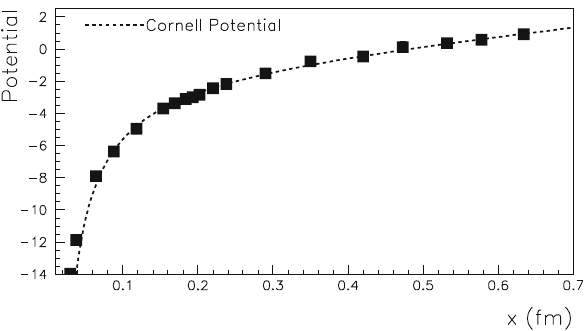
Fig. 8 High-temperature potential from the g ( x ) 2 φ 4 theory as a func- tion of distance after adding the runnings of g 2 and of m eff . The strong interaction’s Cornell potential is shown by the dashed line